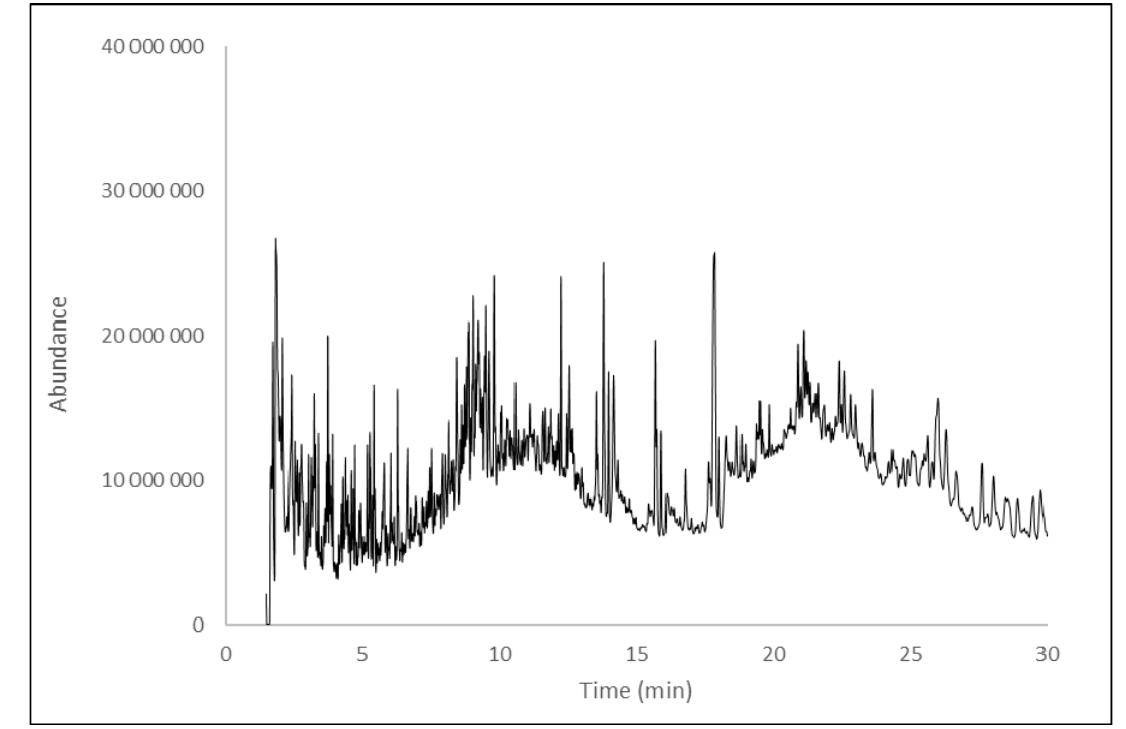
Figure 10. Py-GC-MS chromatogram of the S.2 mortar sample’s binding media.